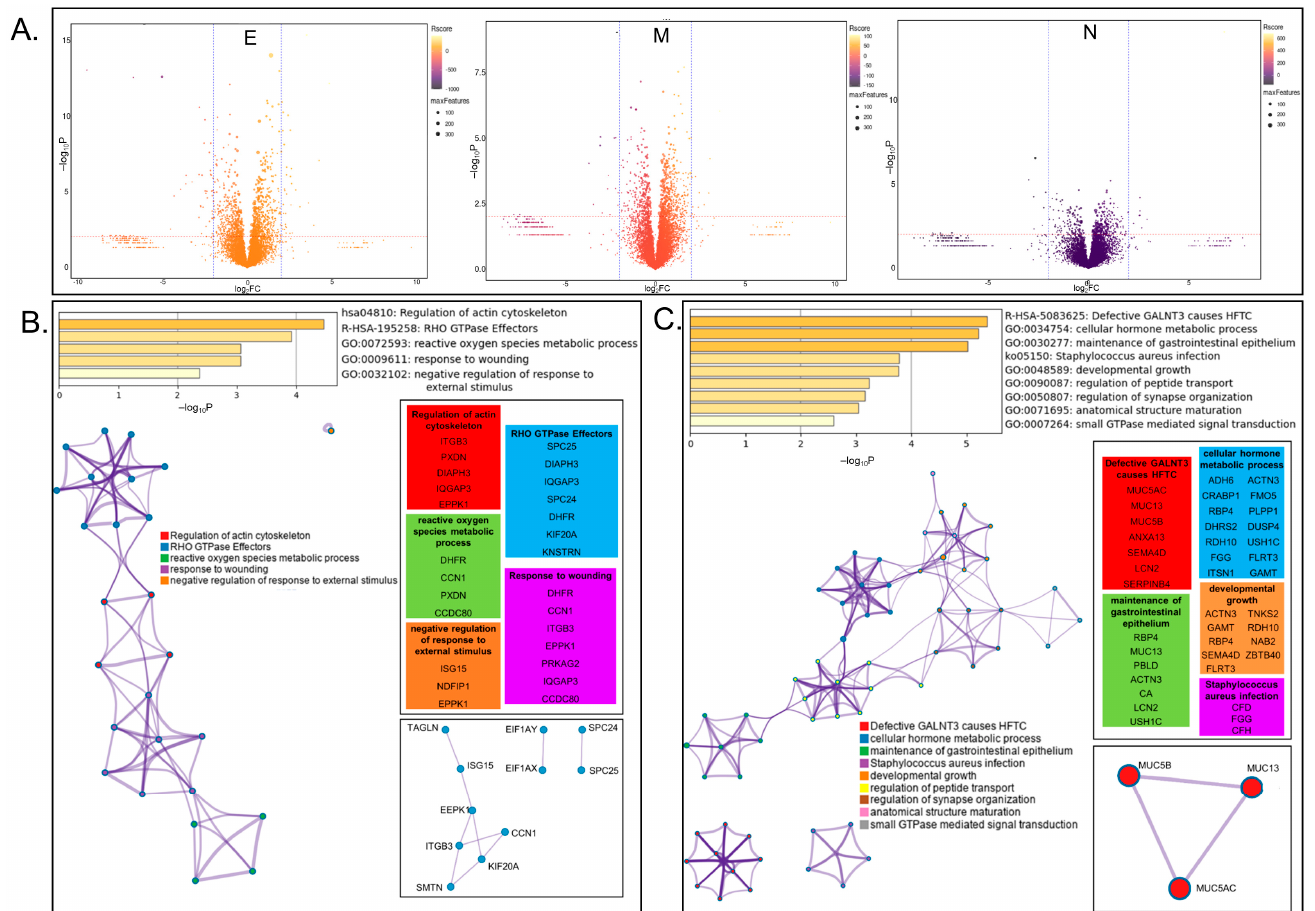
Figure 3. Analysis of proteins influenced by expression of viral structural E, M, and N proteins. ( A ) Volcano plot visualization of global changes in host-protein expression in cells expressing viral proteins Envelope (E), Membrane (M), or Nucleocapsid (N). Protein identifications are available on the COVID-19 Proteomics Resource website. ( B ) Metascape analysis of significantly upregulated proteins including enriched terms, cluster visualization, and interactions. ( C ) Metascape analysis of significantly downregulated proteins including enriched terms, cluster visualization, and interactions.